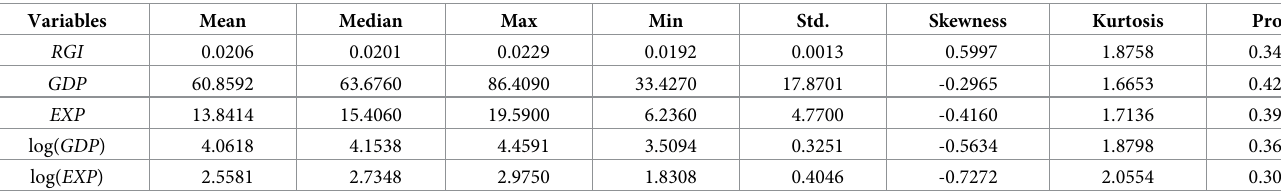
Table 2. Descriptive statistical results of variables at the world